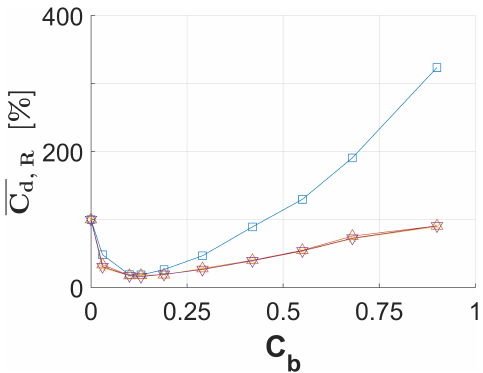
Figure 5. Mean drag coefficient relative to a non-blowing configuration against non-dimensional base bleed rate for constant (- (cid:3) -) [19] and pulsating base bleeds at 100 Hz (- (cid:52) -), 150 Hz (- × -) and 200 Hz (- (cid:53) -).